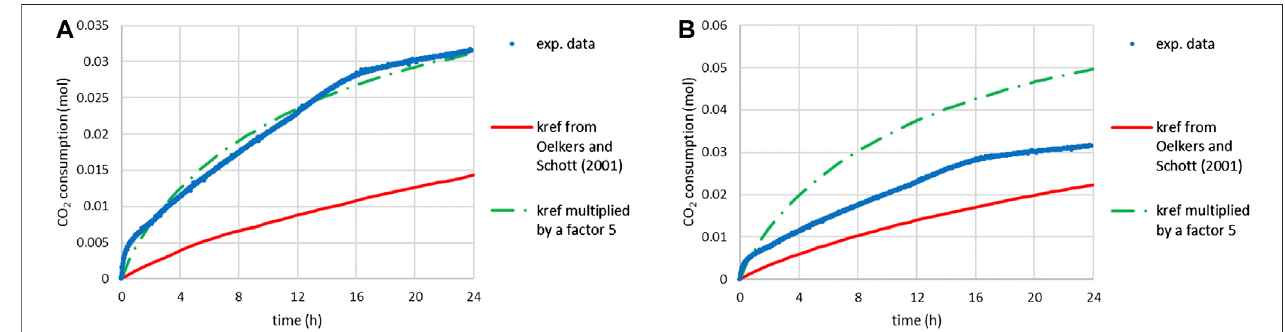
FIGURE 10 | Time-CO 2 consumption during slag carbonation (T (cid:2) 180 ° C, P CO2 (cid:2) 20 bar) under attrition with quartz sand: comparison of experimental data and predictions of scenario 1 (assuming a reaction-limiting process): (A) for system 2 (including main and secondary elements) and (B) for system 1 (limited to the main elements) with inhibition of minnesotaite